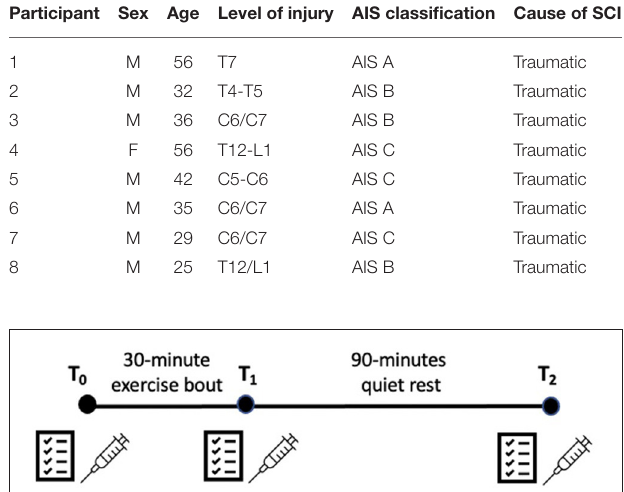
FIGURE 1 | Graphical representation of sub-maximal exercise protocol. Questionnaire symbol = neuropathic pain scale, felt arousal scale and feeling scale; syringe symbol = blood